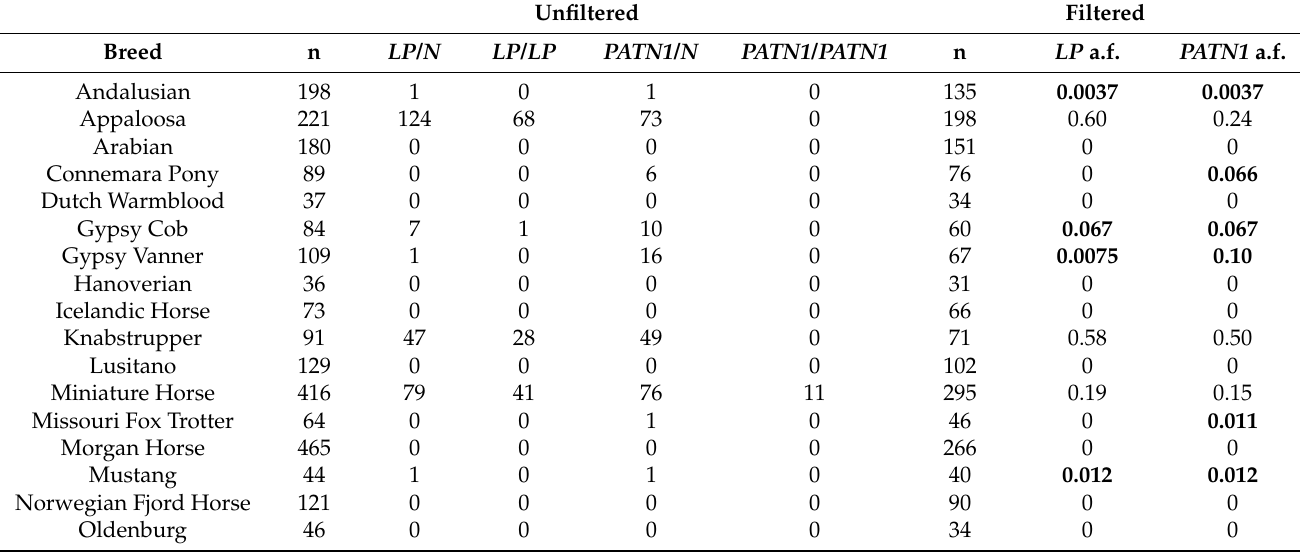
Table 5. Number of individuals (n) genotyped for LP and PATN1 before and after filtering for relatedness, genotype counts per breed, and estimated allele frequencies (a.f.) for the LP and PATN1 variants across 28 breeds. Bolded a.f. represents breeds in which the presence of the allele and a.f. are reported for the first time.